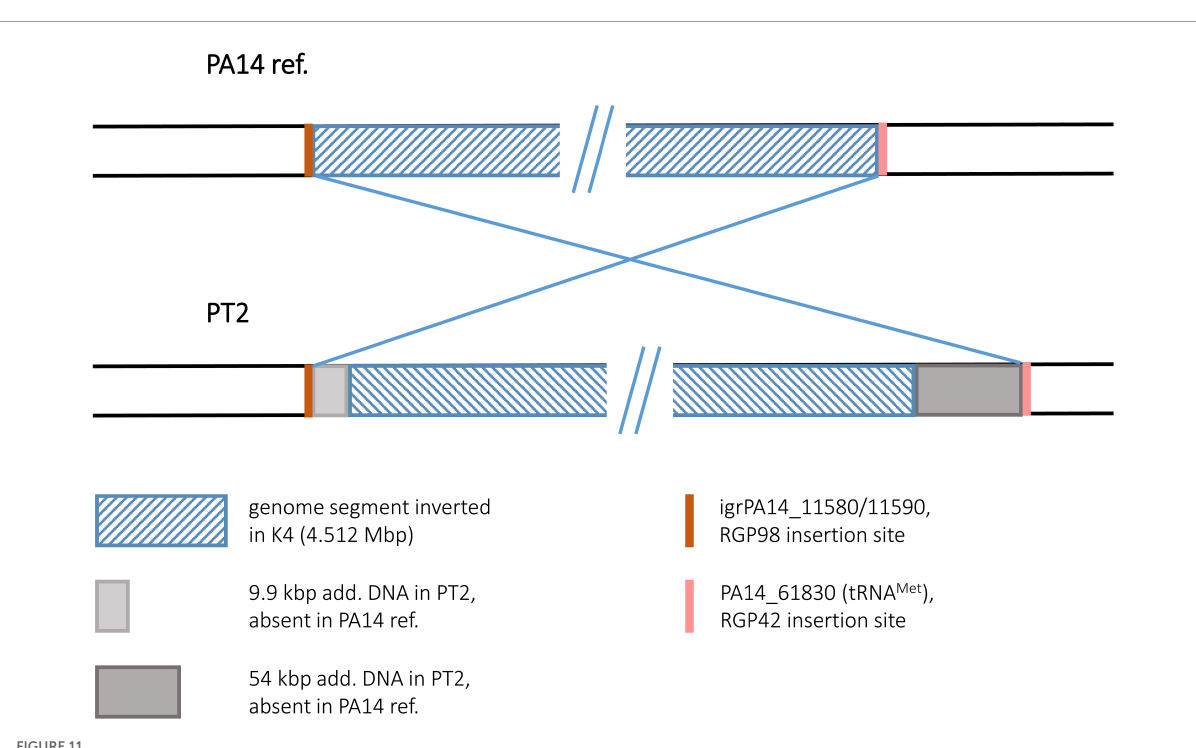
that were based on high-throughput short-read